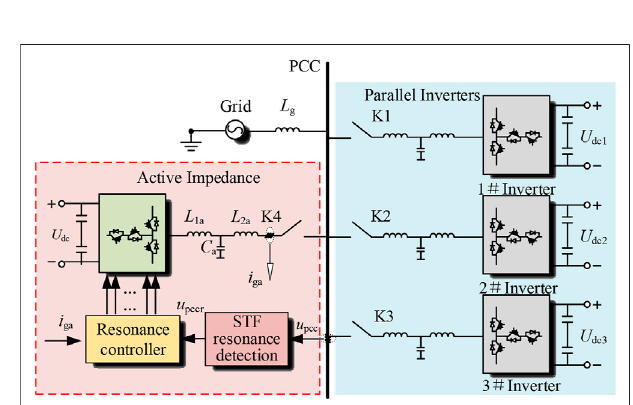
FIGURE 13 | Nyquist plot of impedance ratio under different Lg.